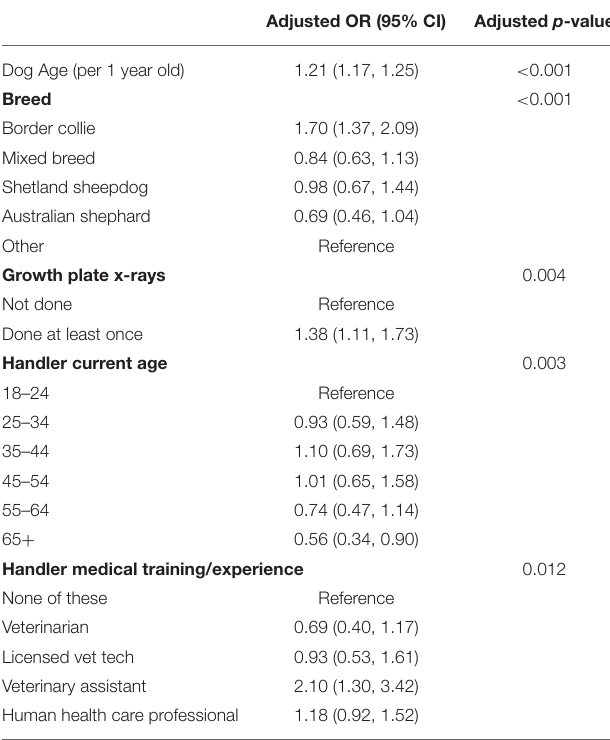
TABLE 5 | Coefficients from final adjusted model of risk factors of severe